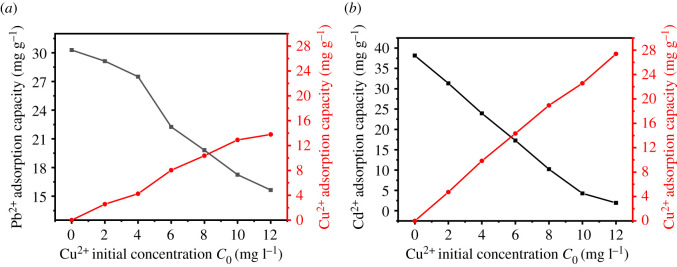
The influence of Cu2+ concentration on the adsorption of Pb2+ and Cd2+.